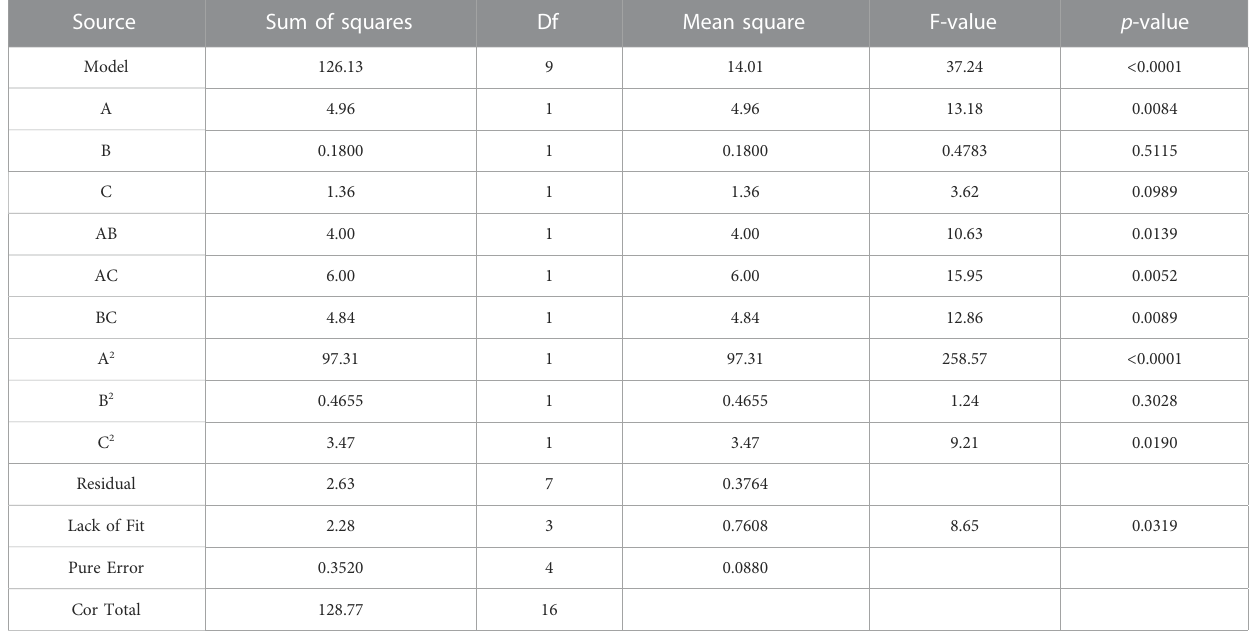
TABLE 3 Regression model ANOVA